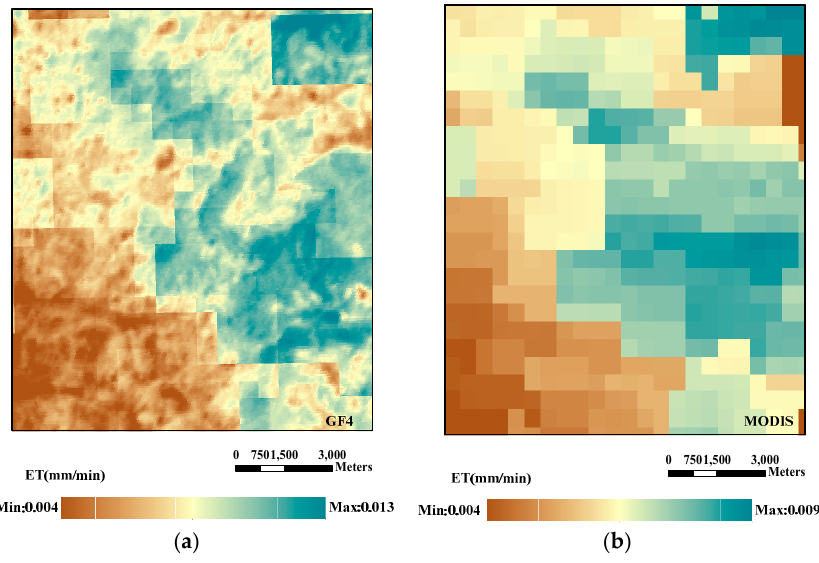
Figure 4. ET of GF-4 at 11:36 ( a ) and ET of MODIS at 11:35( b ) in area CG.